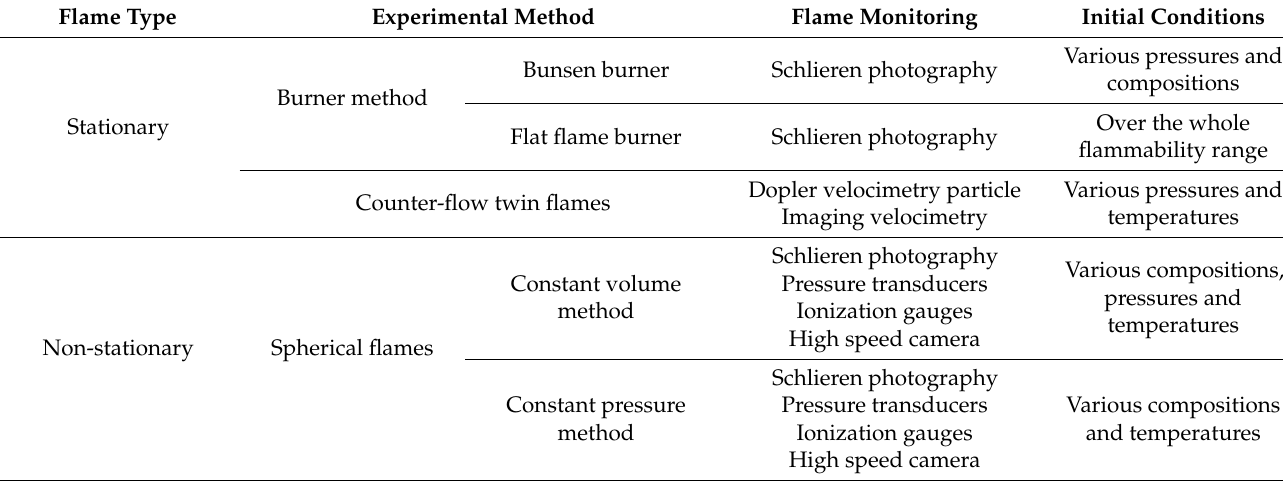
Various pressures and